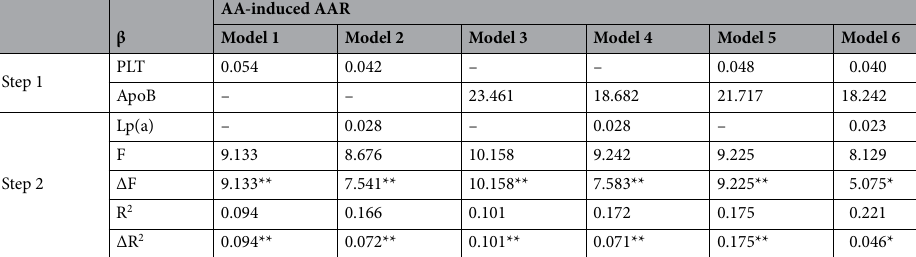
Table 3. The results of the hierarchical multiple regression analysis regarding the association of AA-induced AAR and characteristics. *P < 0.05, **P < 0.01. AA arachidonic acid, AAR average aggregation rate, Lp ( a )